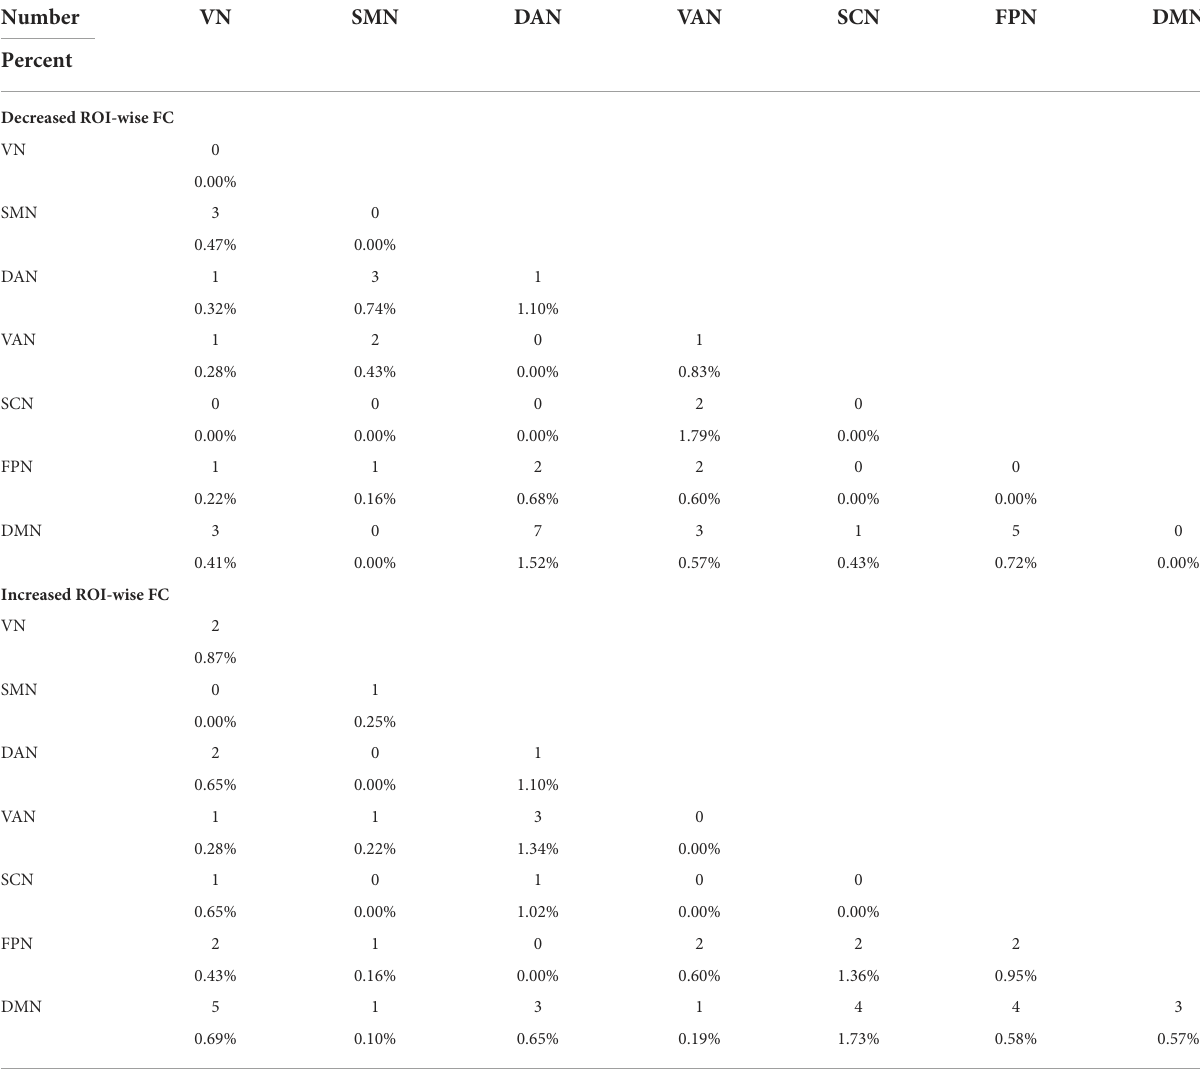
TABLE 3 Number and ratio of decreased and increased ROI-wise FC between acute SD after acupuncture and RW state. Number VN SMN DAN VAN SCN FPN DMN